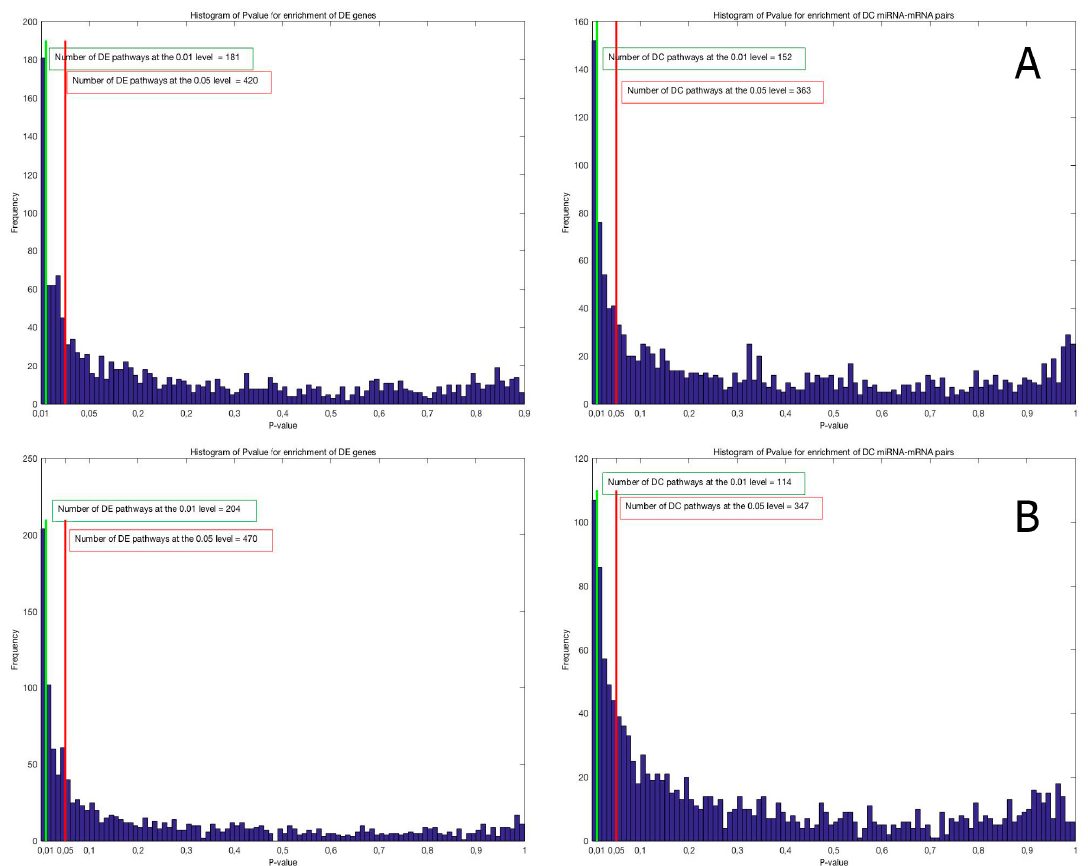
Figure 2. ( A ) Histogram of differentially expressed (DE) and differentially co-expressed (DC) enrichment p -values for the Gene Ontology term; ( B ) Histogram of differentially expressed (DE) and differentially co-expressed (DC) enrichment p -values for the canonical pathways.